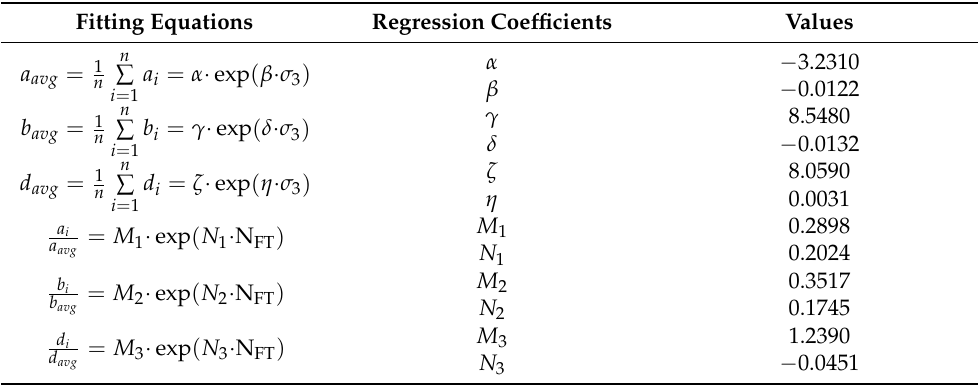
Table 2. Regression coefficients for model